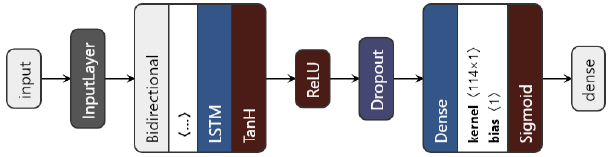
Figure 6. The proposed LSTM